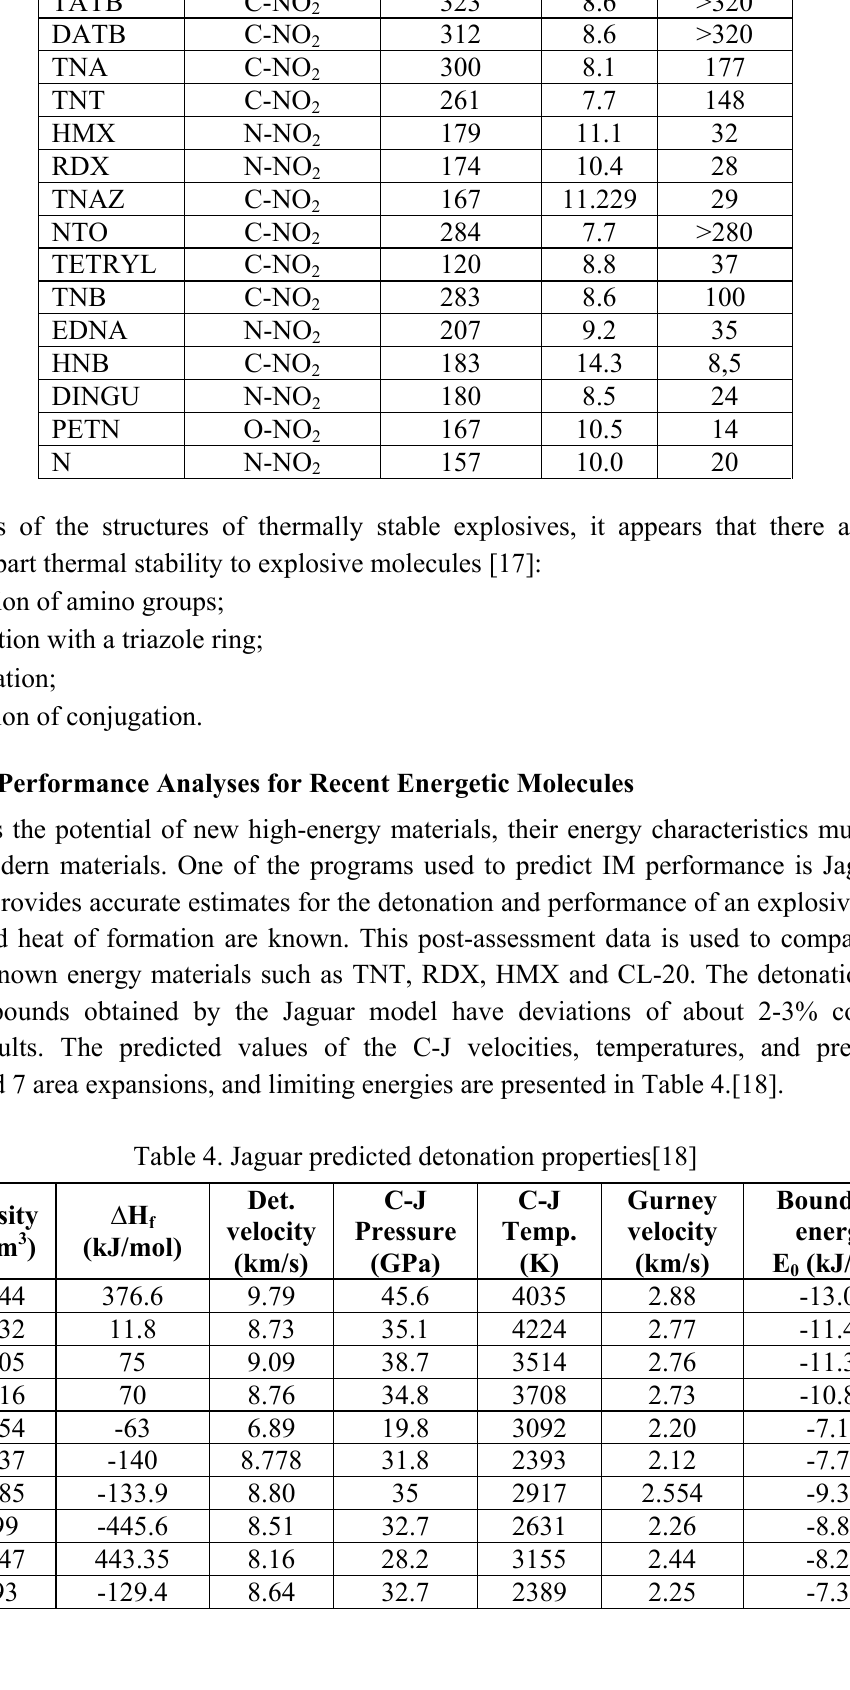
Table 3. Bond strength (De) of the weakest bond, energy content (Ed, kJ/cc), impact sensitivity H